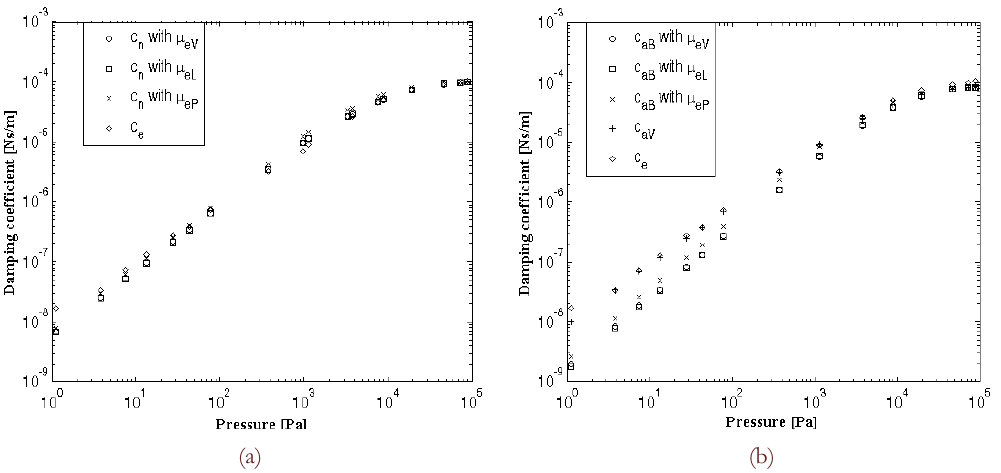
Figure 4: Comparison of the experimental data reported by Sumali [3] with the numerical (a) and the analytical results (b).